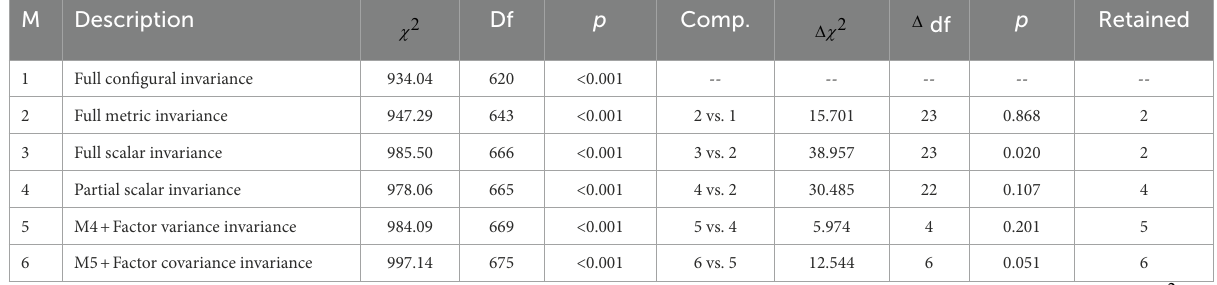
TABLE 2 Model comparisons for measurement invariance